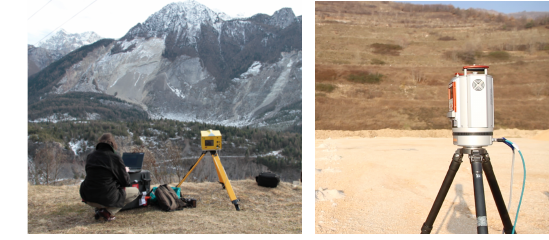
structured-lightFigure 1. Time of flight laser scanner